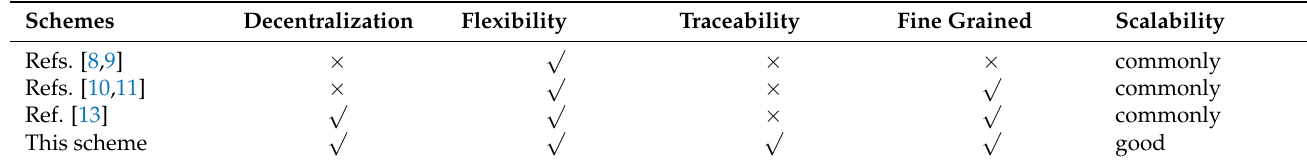
Table 2. Function